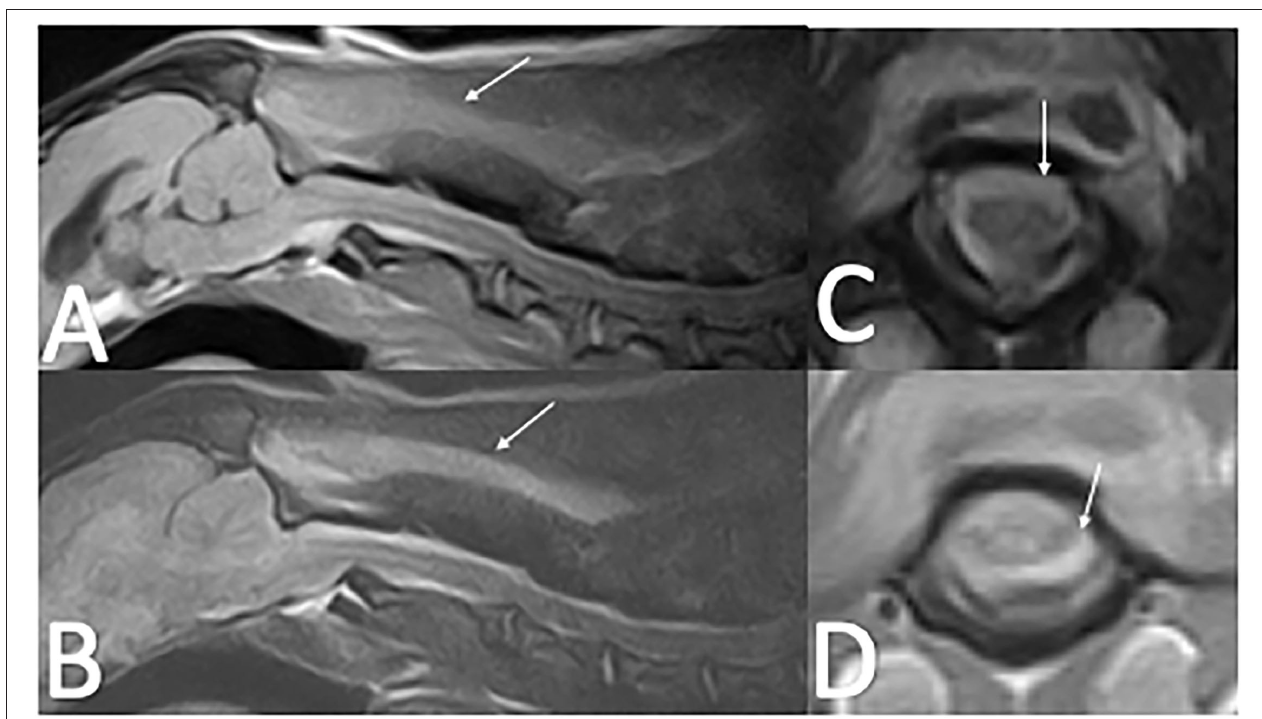
FIGURE 3 | Repeat Cervical MRI of case two following cerebellomedullary cisternal CSF tap. (A) —T2W sagittal image of the cervical spine with T2 hyperintensity along the dorsal cervical musculature fascial planes (arrow) with increased T2 hyperintensity dorsal to the spinal cord at C1–C2 compared to Figure 2 . (B) —T1W sagittal image of the cervical spine with T1 hyperintensity along the dorsal musculature fascial planes (arrow). (C) —T2W transverse image at the level of C1 with T2 iso to hyperintense material resulting in spinal cord compression (arrow). (D) —T1W transverse image at the level of C1 with T1 iso- to hypointense material resulting in spinal cord